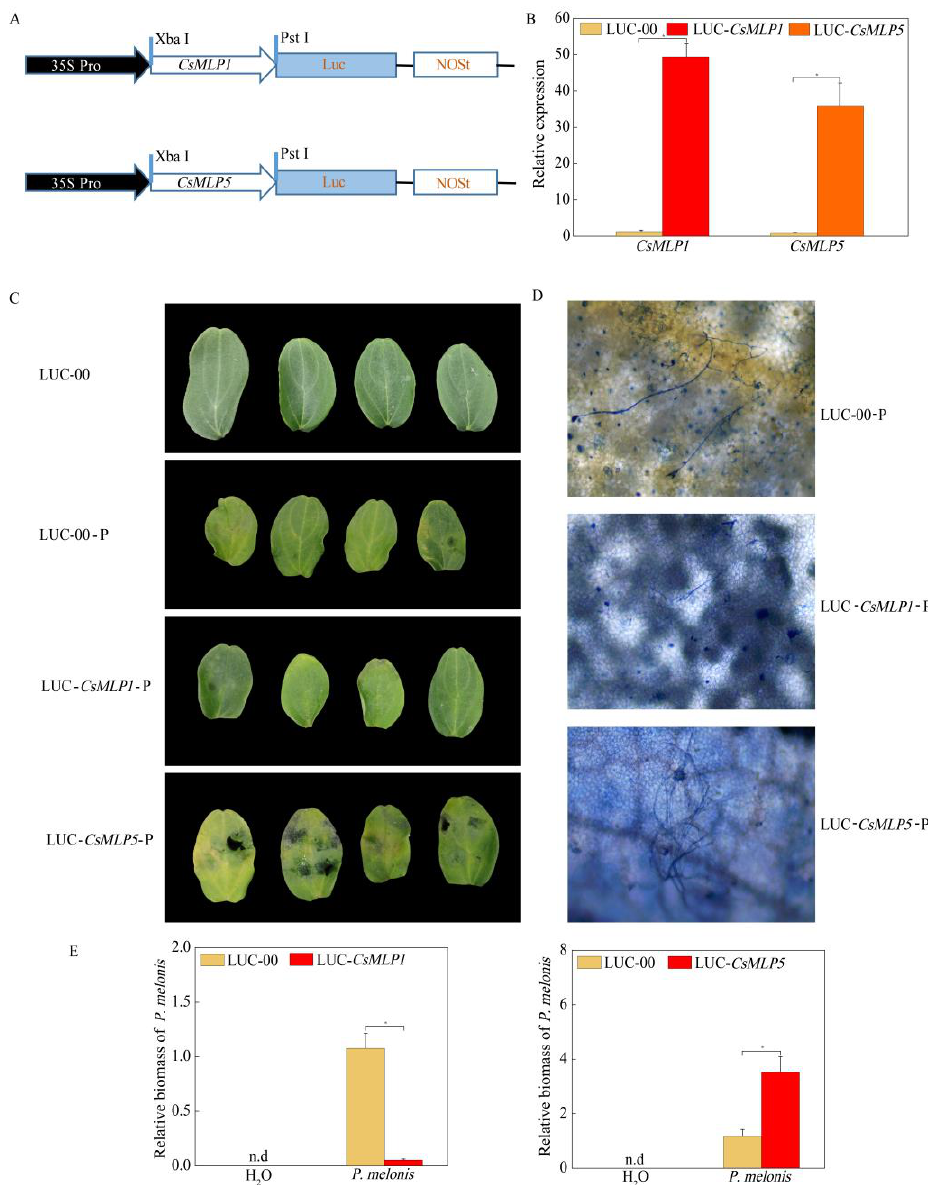
Figure 9. Resistance identification of transient overexpressing plants on 72 h after P. melonis inoculation. ( A ) Schematic of the CsMLP1 -Luc and CsMLP5 -Luc constructs. CsMLP1 and CsMLP5 were between 35S Pro and Luc proteins. ( B ) Transgenic plants were identified by qRT-PCR. ( C ) The water-soaking lesion areas were observed in CsMLP1 - and CsMLP5 -transient overexpressing cucumber cotyledons. ( D ) Invasive hyphae extend on the epidermis of CsMLP1 - and CsMLP5 -transient overexpressing cucumber cotyledons stained with lactophenol-trypan blue. ( E ) P. melonis biomass accumulation in CsMLP1 - and CsMLP5 -transient overexpressing cucumber cotyledons. Data are means ± standard errors from three independent experiments. The asterisks indicate statistically significant differences compared with empty vector control plants (LUC-00) ( p < 0.05). XbaI and Pst I, restriction endonuclease; Luc, luciferase; NOSt, NOS terminator.